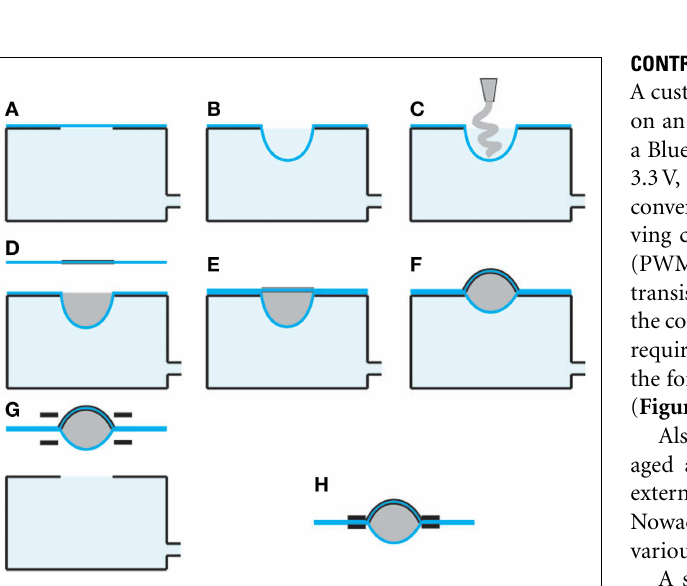
FIGURE 3 | Fabrication steps for a bubble-like HC-DEA .The passive membrane is placed over an empty chamber having a circular hole (A) .Vacuum is applied in order to deform the membrane and create a cavity (B) .The cavity is filled with silicone grease (C) .The active membrane is coupled to the other membrane (D) and bonded to it (E) .Vacuum is released (F) .The membranes are removed from the vacuum chamber (G) , and bonded to a plastic frame (H)